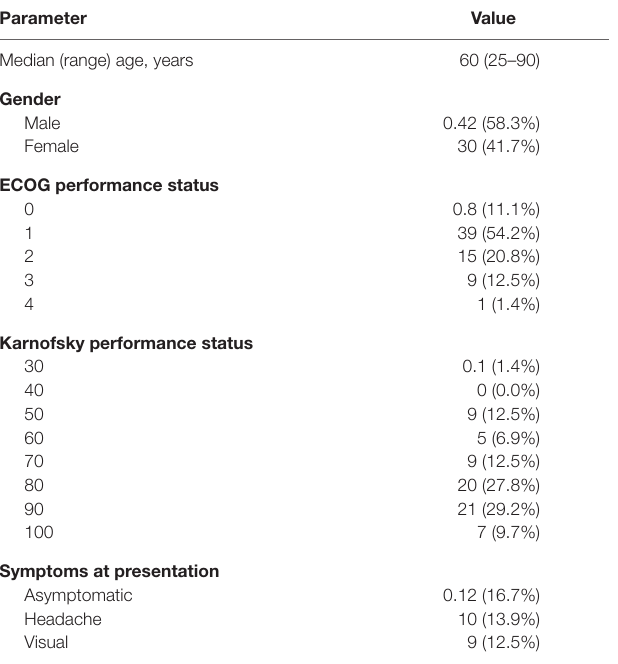
TaBle 1 | clinical and treatment characteristics of the study